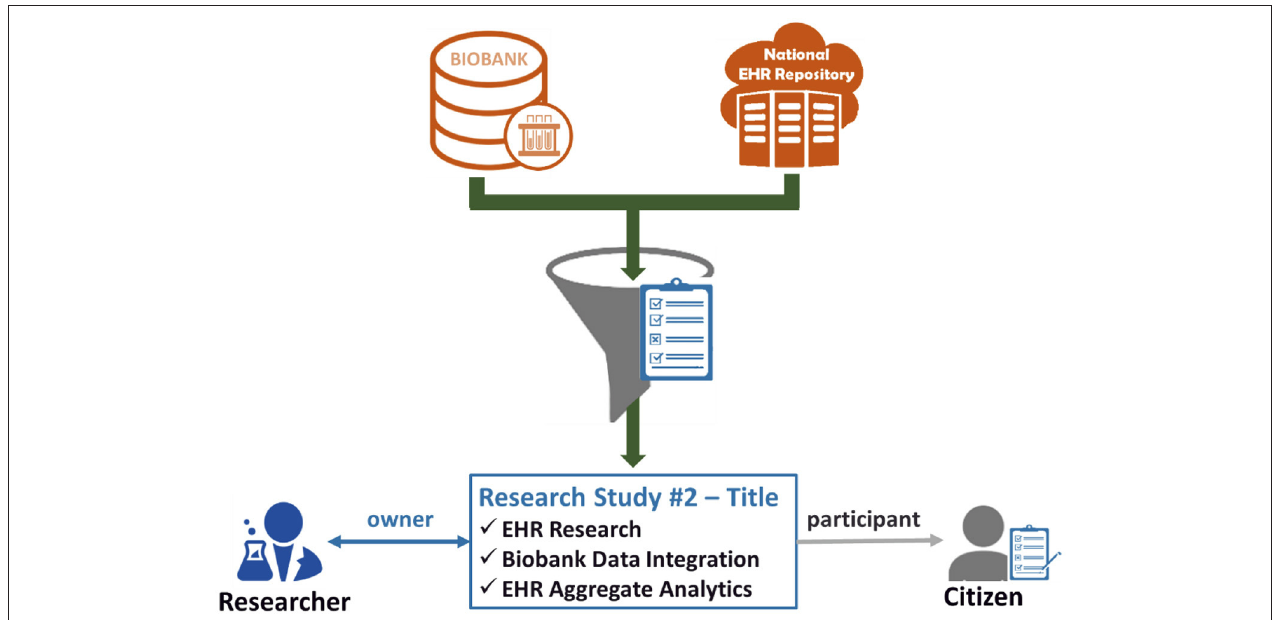
FIGURE 3 | Citizen’s biobanking and national electronic health record (EHR) data flow controlled by the citizen’s informed